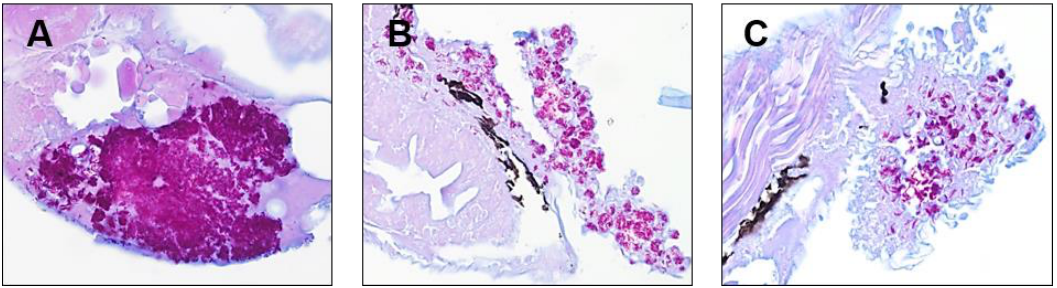
Figure 5. Multiple acid-fast bacilli are present in the ZF. ZF with M. abscessus CIP 104536 T R morphotype histopathological analysis was performed by Ziehl–Neelsen (acid-fast) staining. Non-treated M. abscessus CIP 104536 T R-infected ZF ( A ). M. abscessus CIP 104536 T R-infected ZF treated with RFM O ( B ) and CLR ( C ). Magnification, ×